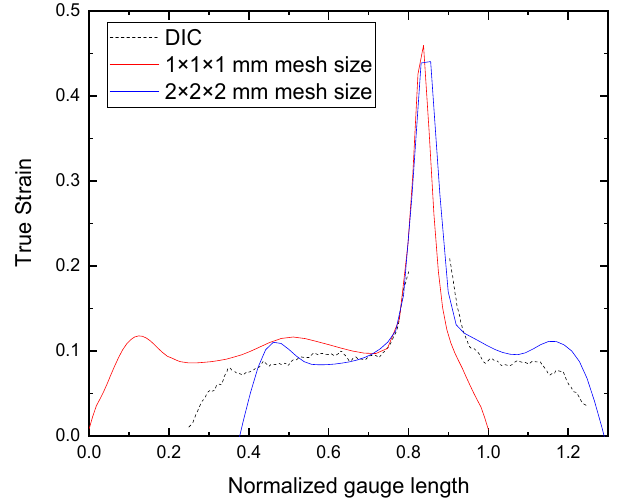
Figure A8. Comparison between DIC and FE simulation strain map results for smooth specimens at the last captured frame before rupture at 0.001 s − 1 strain rate for 1 × 1 × 1 and 2 × 2 × 2 mm average mesh sizes.